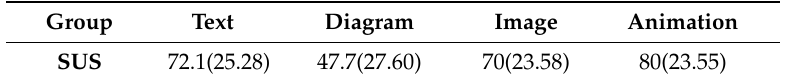
Table 9. Average means and standard deviations of the four interfaces according to the SUS results (standard deviation in parentheses; full score =